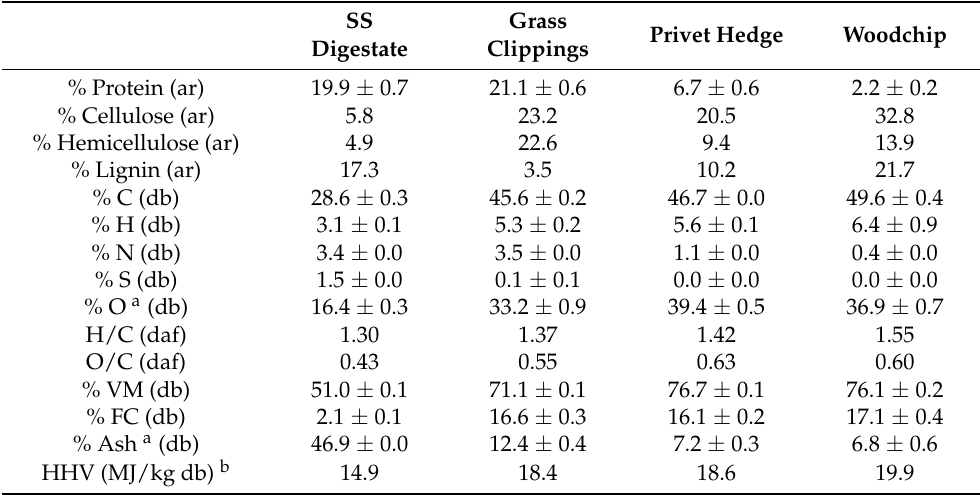
Table 2. Composition analysis of digestate and lignocellulosic